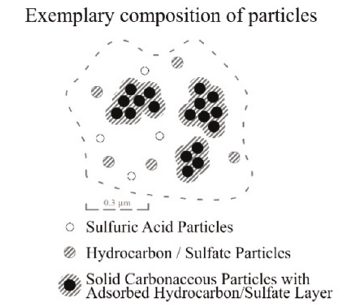
Fig. 2. Typical composition and structure of engine exhaust particles [10] The influence of the fine solid particles on human health increases in inversely proportion to their size. Research confirms that particles from the PM category are charac- 2.5 terized by greater health affect than PM . Particles under 10 a diameter of 2.5 µm are able to penetrate the blood-air blood throughout the human body [12]. Engine